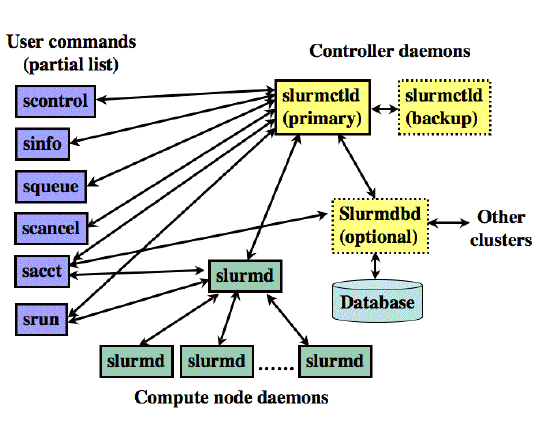
Figure 3. Slurm schemas and communication process [7]. Slurm uses server-client mode to manage the job